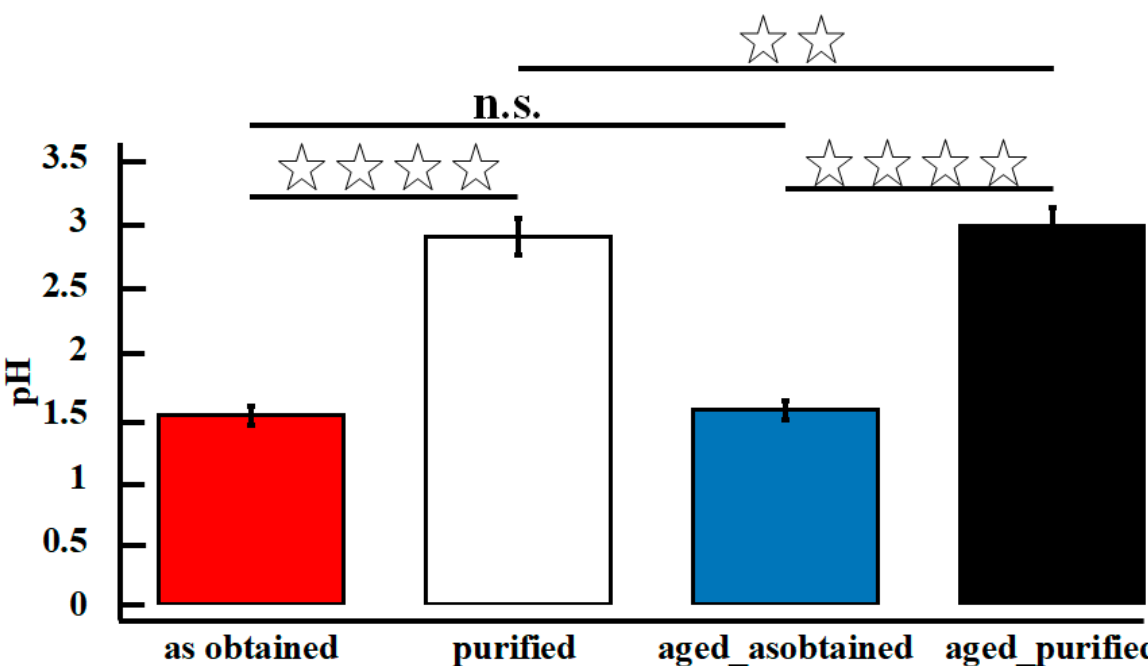
Figure 4. Results pH measurements for the evaluated samples. Differences were assigned as significant for: * p < 0.05, ** p < 0.01, *** p < 0.001, **** p < 0.0001.